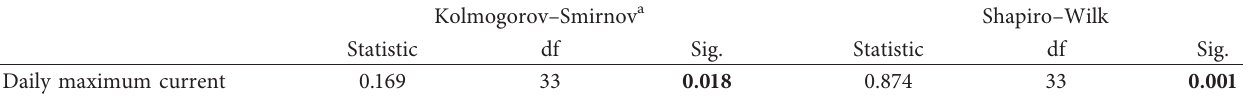
Table 1: Tests of normality.